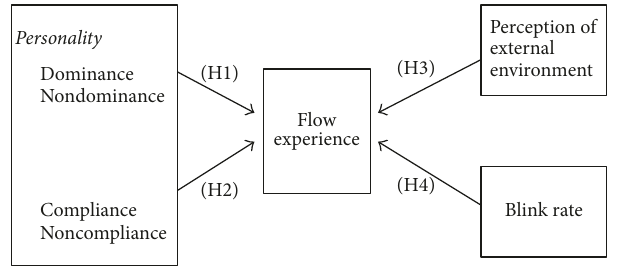
Figure 1: Research